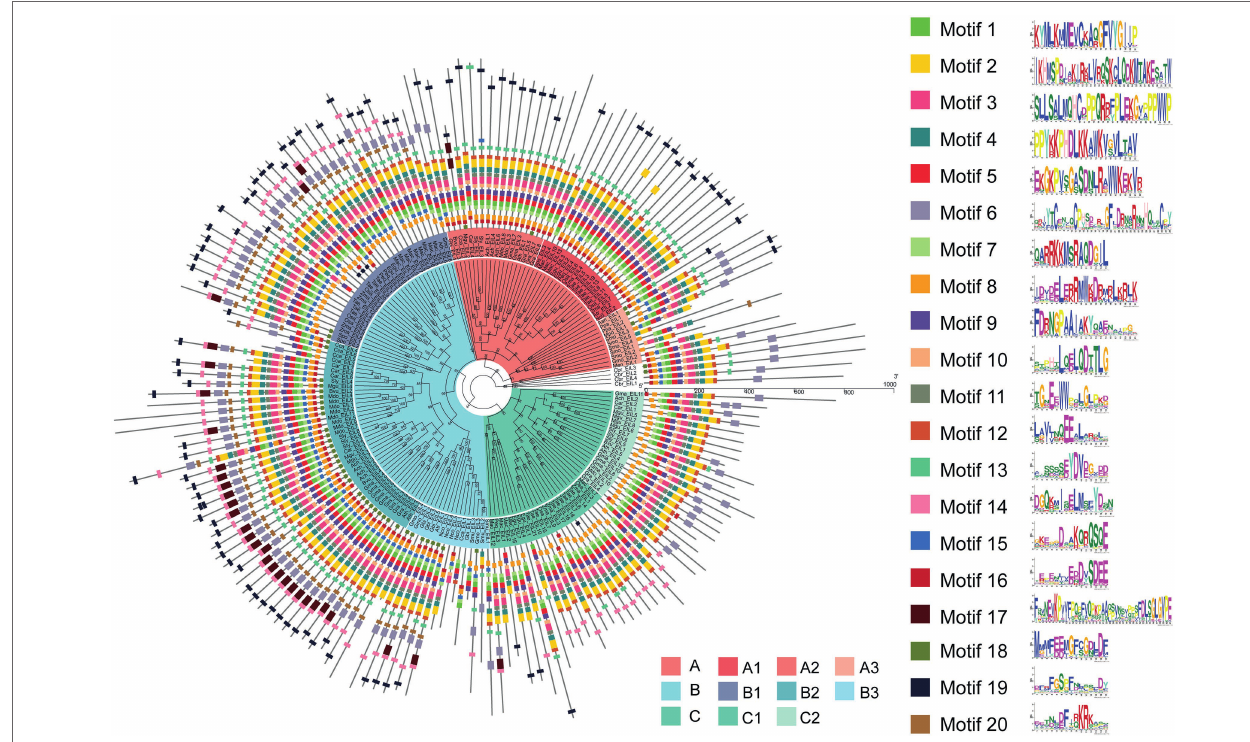
FIGURE 3 | Phylogenetic relationship and conserved motifs of all EILs. A total of 182 EIN3/EIL proteins from 28 species were selected to construct the phylogenetic tree using PhyML by ML method. Conserved motifs of the EIN3/EIL proteins were obtained using the MEME